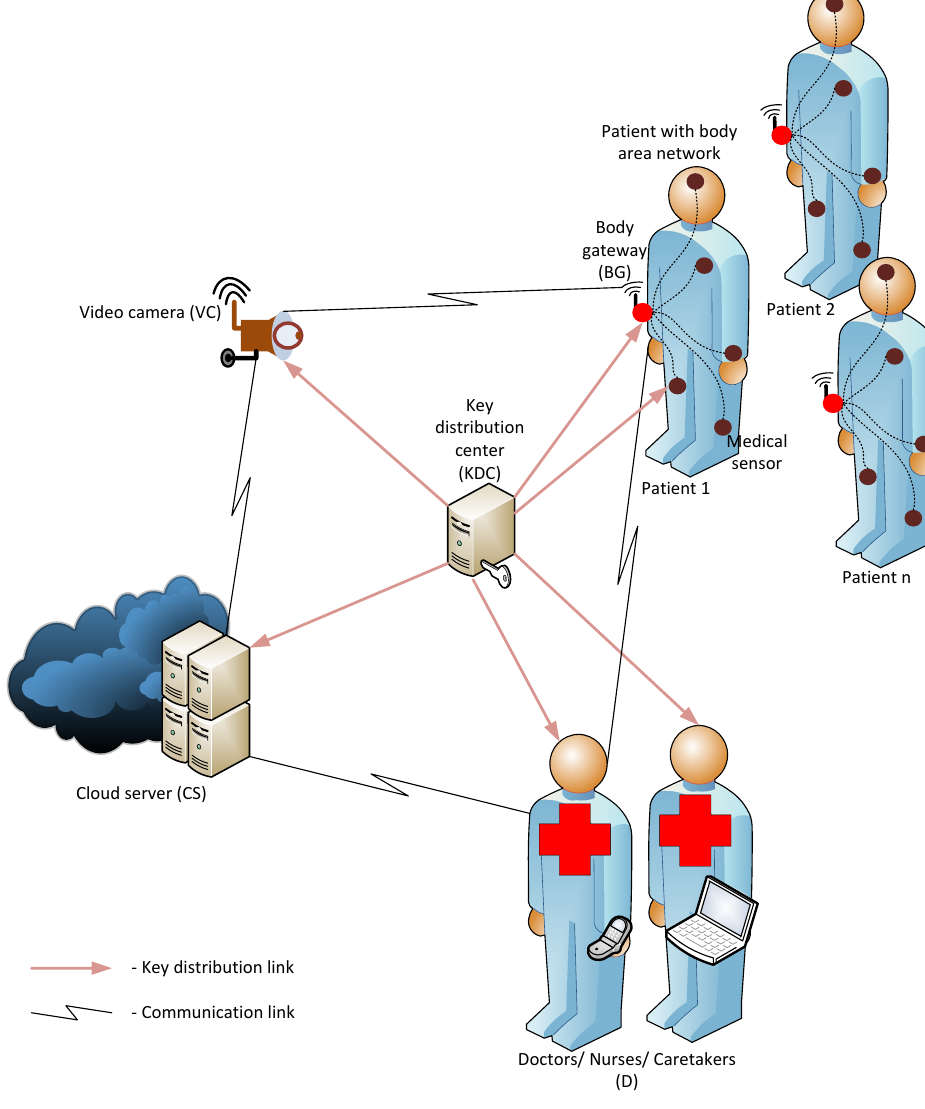
Figure 1. Network system